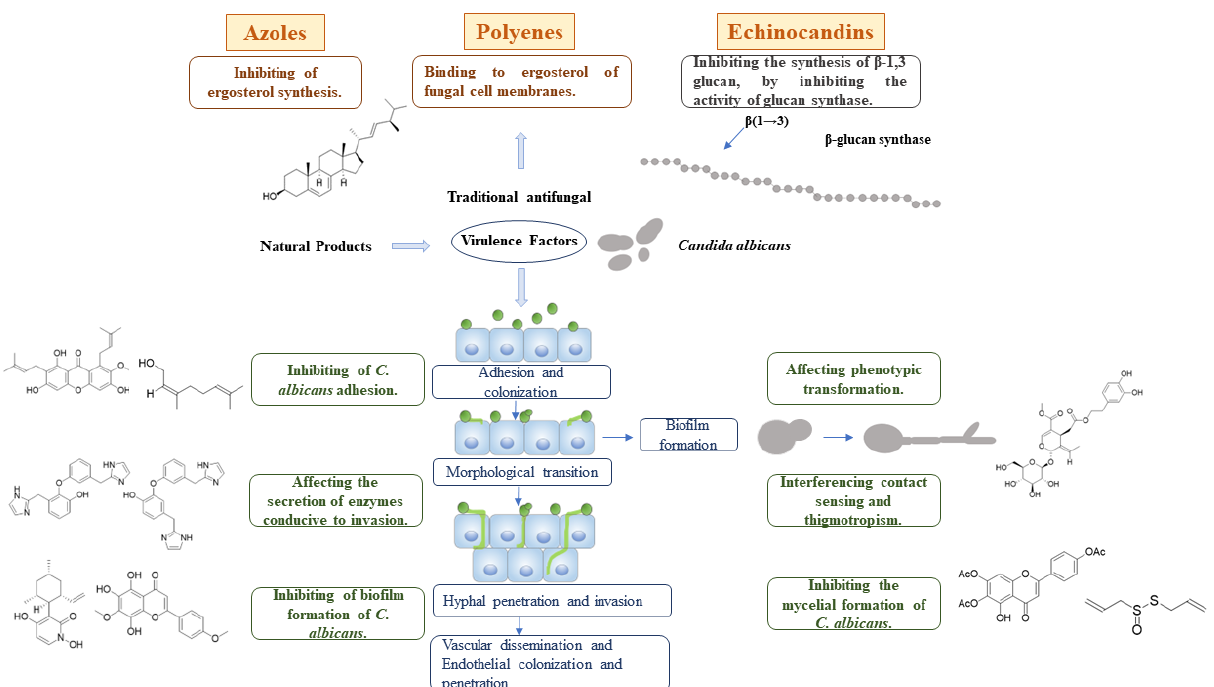
Figure 2. Regulation of traditional antifungal drugs and natural products on virulence factors of C. albicans . Table 2. The effects of natural products on C. albicans virulence factors.